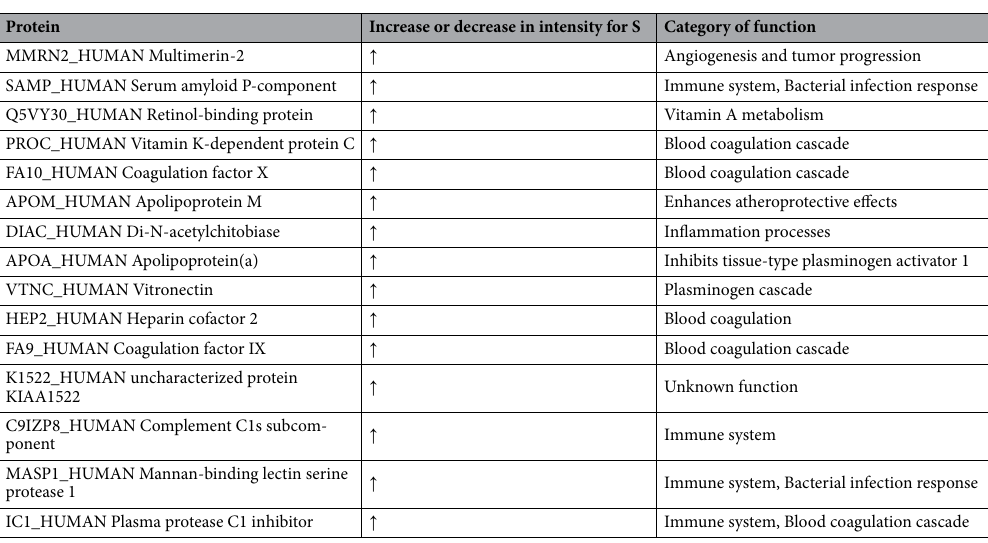
Table 8. The first 15 proteins with the most significant changes in intensities in S versus C. The first 15 proteins with the most significant changes in protein intensity quantification values in a comparison of groups S and